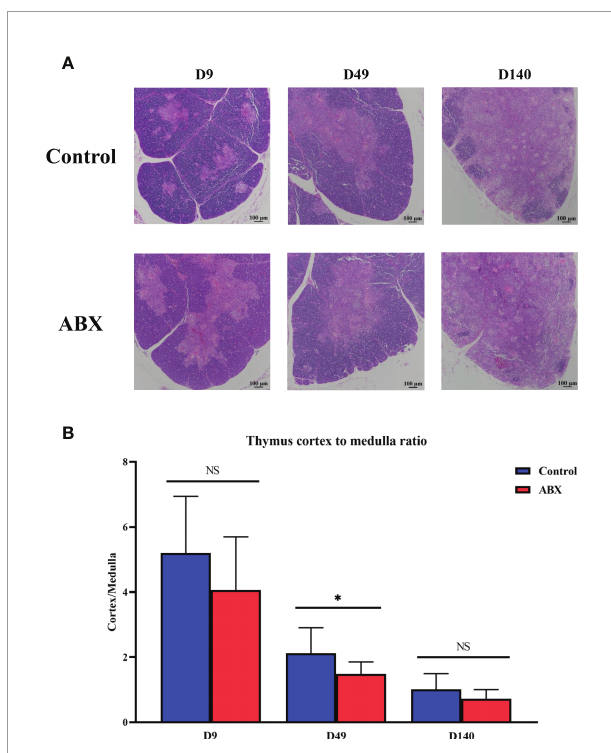
FIGURE 1 | Antibiotic treatment leads to structural changes in the thymic tissue. (A) Light micrograph of the thymus stained with hematoxylin and eosin at different ages. Magni fi cation, ×100; scale bar, 100 m m. (B) Differences in the ratio of thymic cortex to medulla at different ages in the controls (Ctr) and antibiotic-treated chickens (ABX). * p < 0.05; unpaired t -test. n ≥ 10 for each group. ns, not signi fi